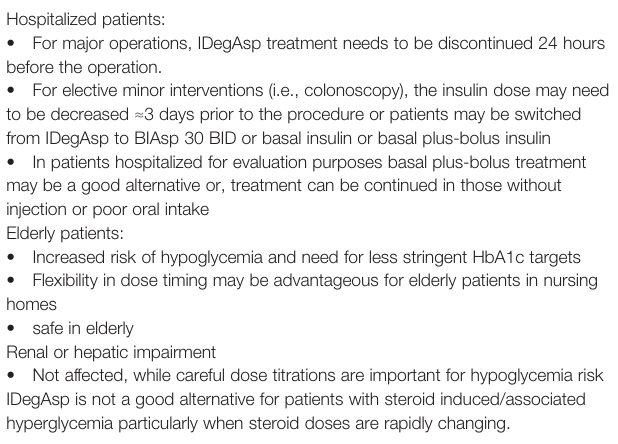
TABLE 10 | Expert Panel Recommendation 10: Use in Special Patient Groups. Hospitalized patients: (cid:129) For major operations, IDegAsp treatment needs to be discontinued 24 hours before the operation. (cid:129) For elective minor interventions (i.e., colonoscopy), the insulin dose may need to be decreased ≈ 3 days prior to the procedure or patients may be switched from IDegAsp to BIAsp 30 BID or basal insulin or basal plus-bolus insulin (cid:129) In patients hospitalized for evaluation purposes basal plus-bolus treatment may be a good alternative or, treatment can be continued in those without injection or poor oral intake Elderly patients: (cid:129) Increased risk of hypoglycemia and need for less stringent HbA1c targets (cid:129) Flexibility in dose timing may be advantageous for elderly patients in nursing homes (cid:129) safe in elderly Renal or hepatic impairment (cid:129) Not affected, while careful dose titrations are important for hypoglycemia risk IDegAsp is not a good alternative for patients with steroid induced/associated hyperglycemia particularly when steroid doses are